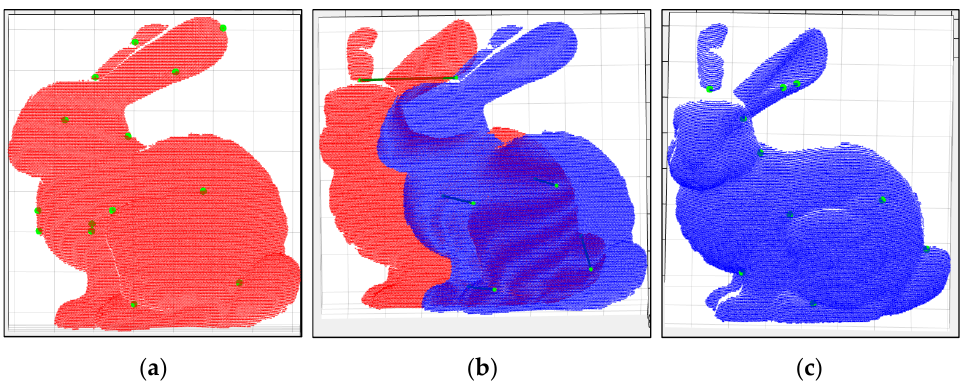
Figure 19. Stanford bunny sculpture: ( a ) detected keypoints in the 1st point cloud using new algo- rithm; ( b ) distribution of the matched keypoints with the new algorithm; ( c ) detected keypoints in the 2nd point cloud using new algorithm.